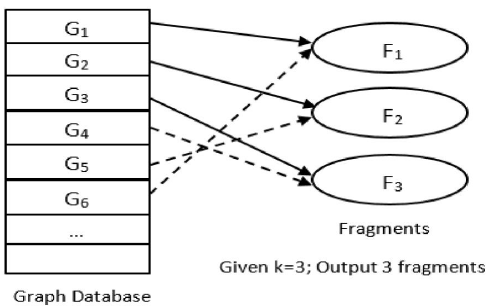
Fig. 18 Data Partition scheme for PartGraphMining [47]